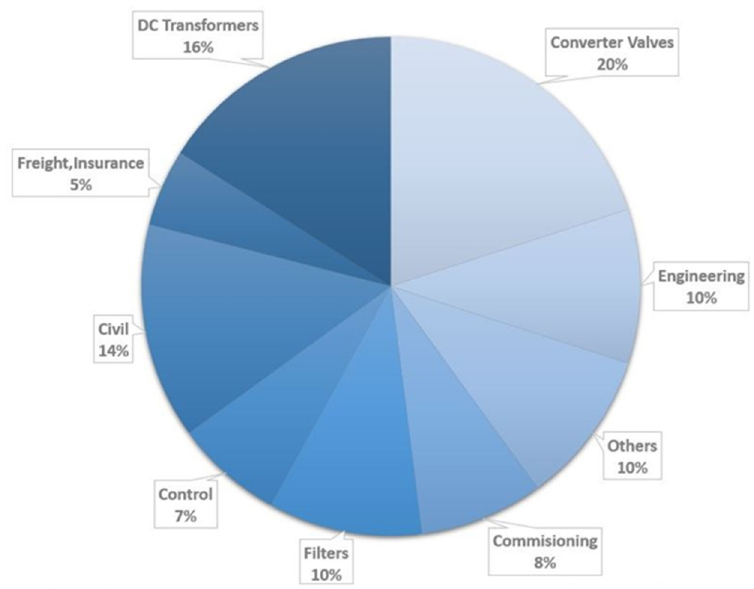
Figure 20. Installation costs—HVDC converter station.